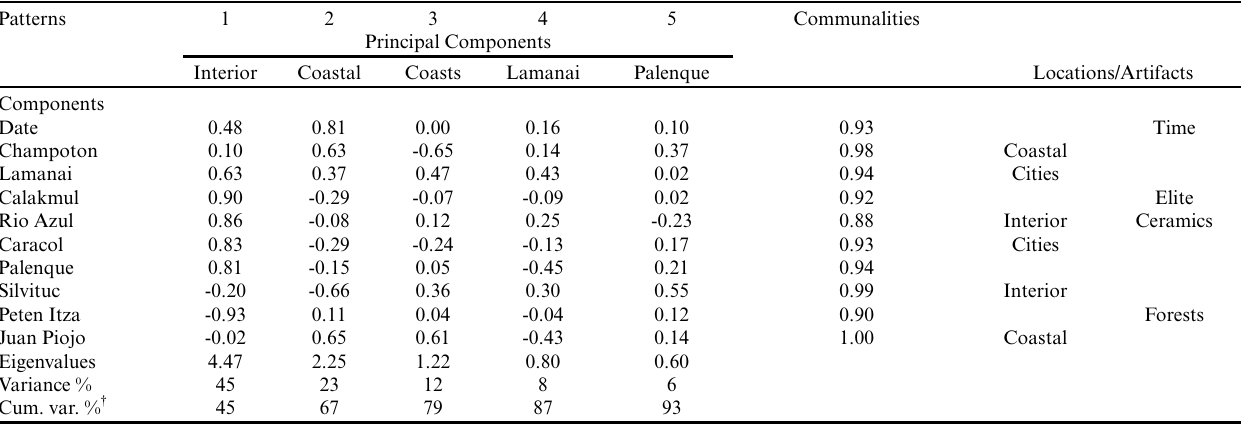
Table 4 . Principal components